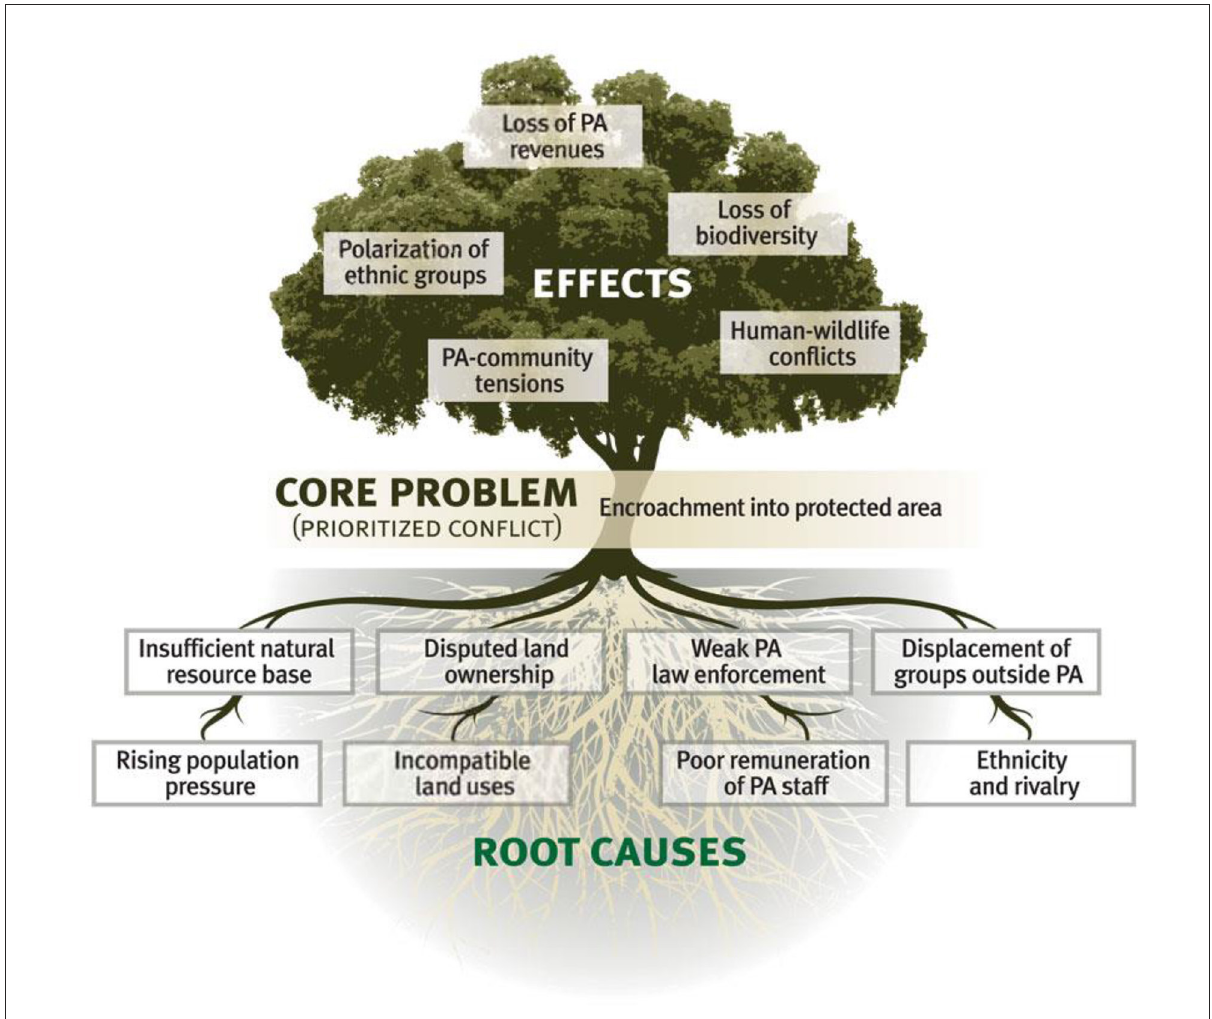
FIGURE3 Problem tree